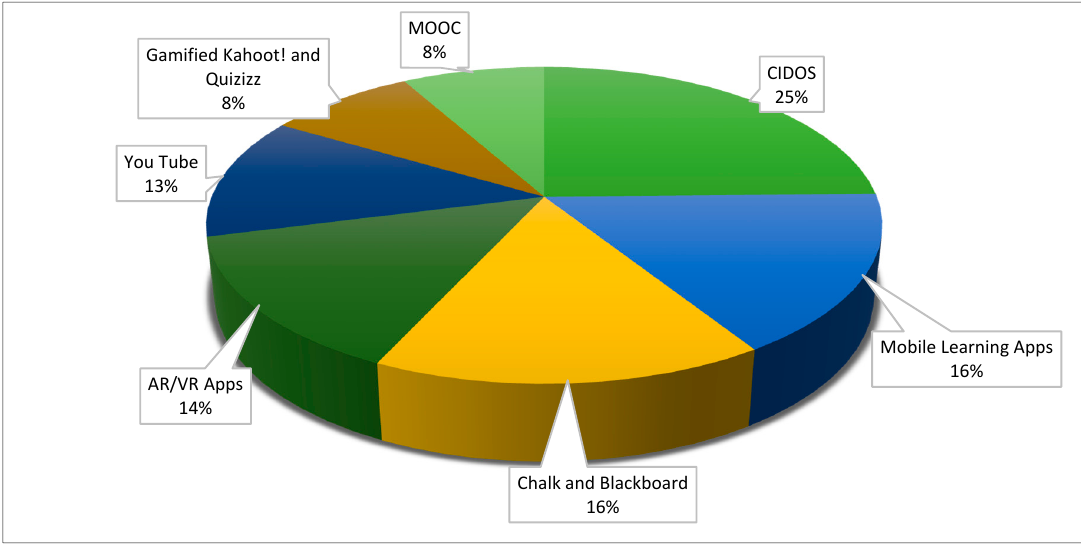
Figure 3. Digital learning platforms and tools preferred by students.